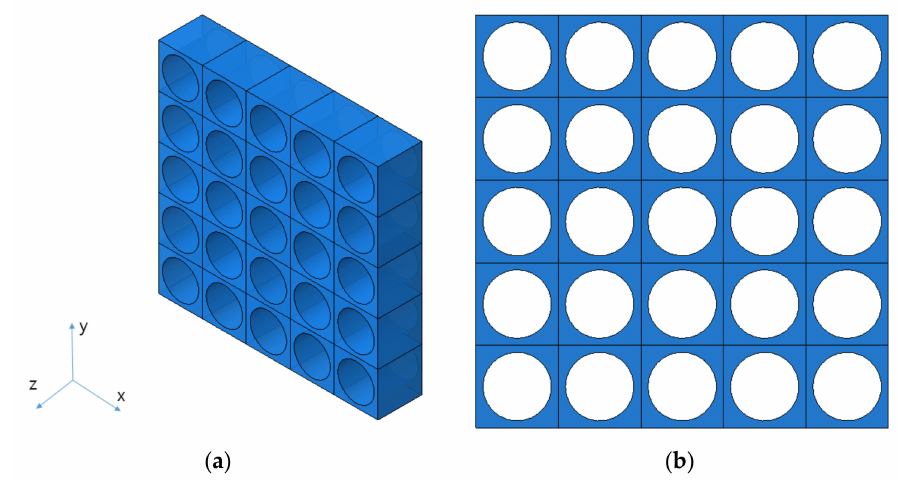
Figure 3. The shape of circular pores. ( a ) Isotropic view. ( b ) Top view.